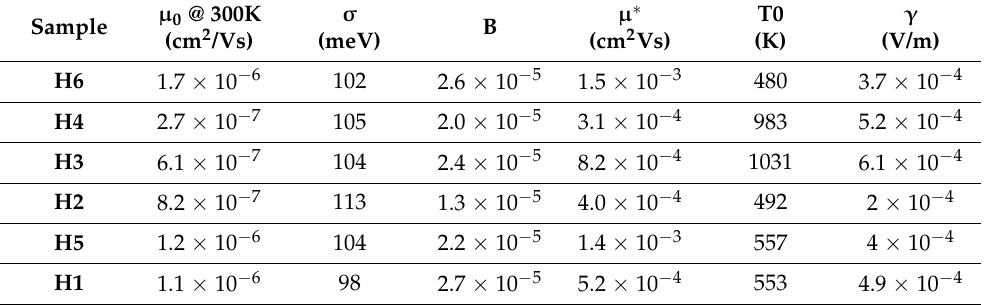
Table 3. Fitting parameters for hole-only devices of Figure 9, extracted from the MG+GDM model. Sample